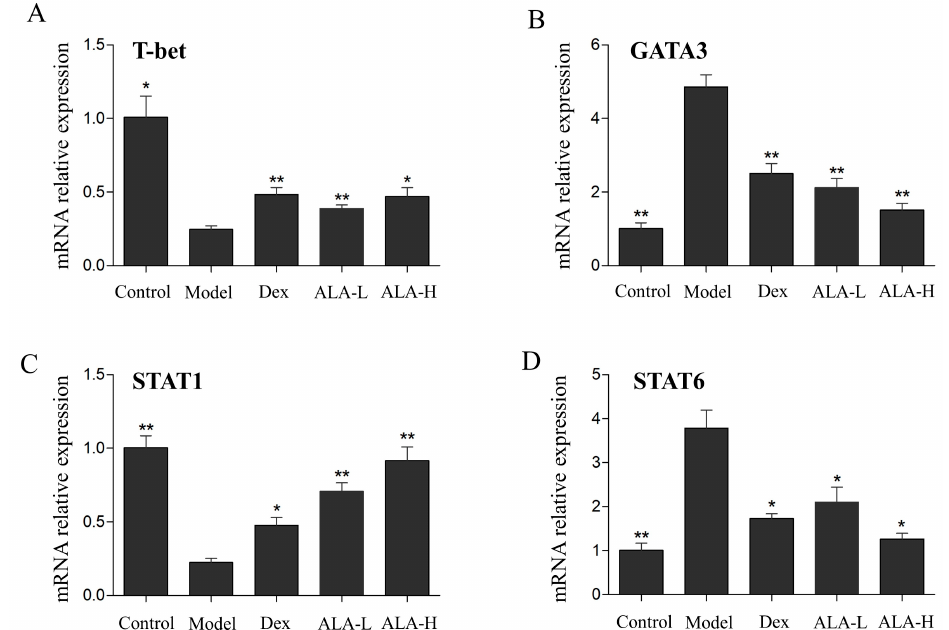
Figure 5. Effect of ALA on the mRNA expression levels of T-bet ( A ), GATA3 ( B ), STAT1 ( C ), and STAT6 ( D ) in the nasal mucosa in AR mice. Between-group comparisons were performed using one-way ANOVA coupled with LSD t -test (equal variances assumed) or Tamhane’s T2 test (equal variances not assumed). Data are expressed as mean ± SD; n = 4; * p < 0.05, ** p < 0.01 versus AR model.